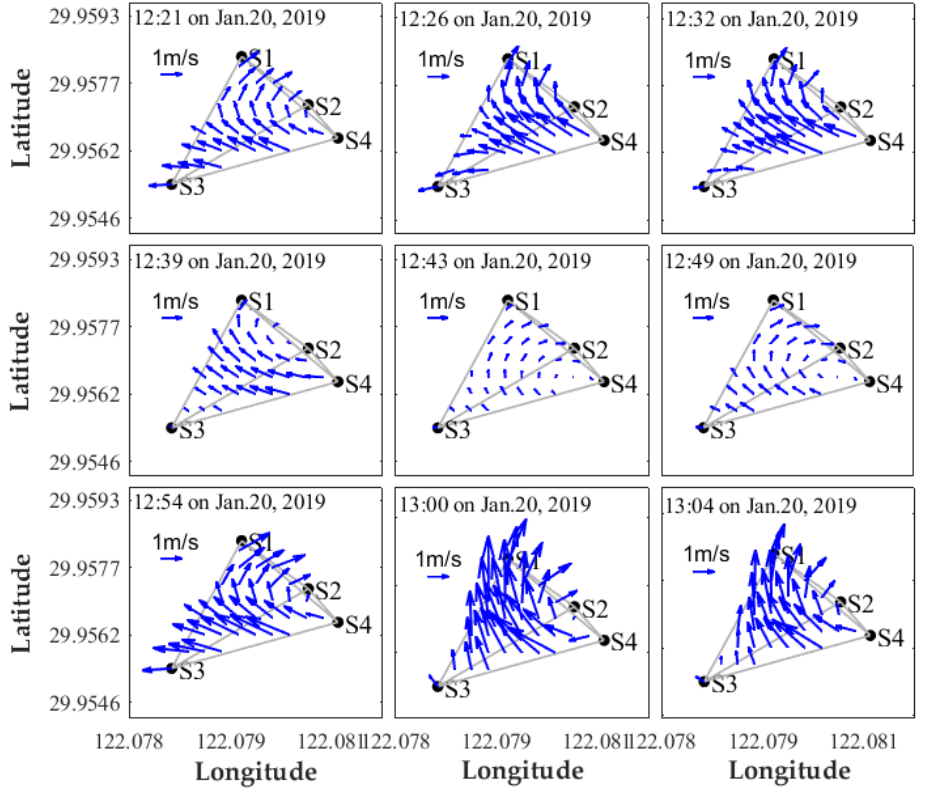
Figure 7. Horizontal velocity fields mapping.